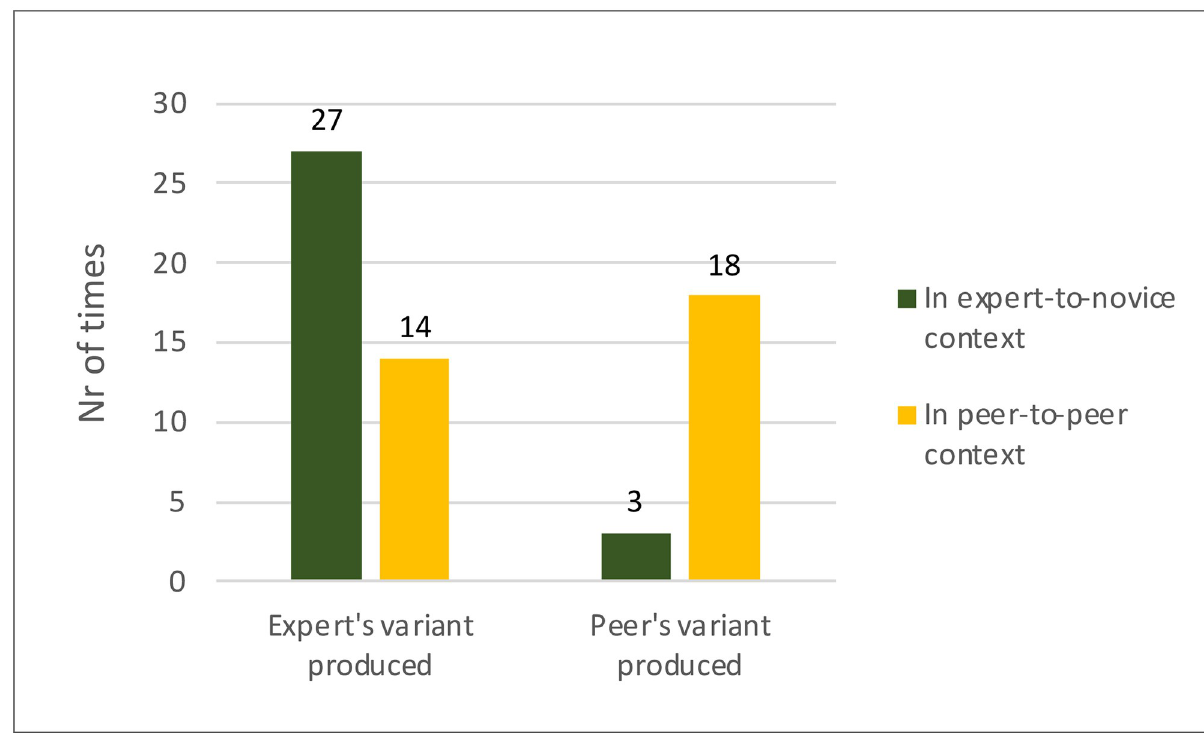
Fig 4. Experimental results showing the number of times the expert’s and peer’s variant strategy was produced in each onward transmission context.